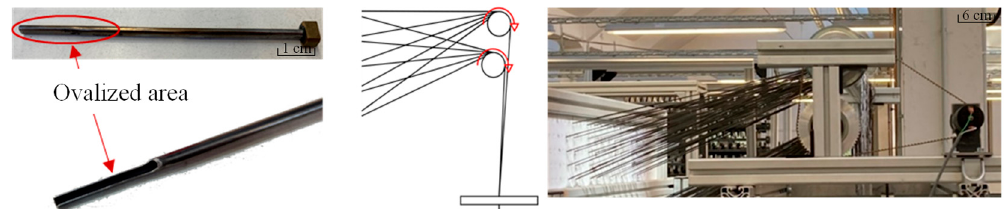
Figure 2. Adaptation measures on the biaxial flat knitting machine: ( left ) opening of the ovalized area of the warp yarn guides; ( right ) implementation of active self-regulating warp yarn delivery.